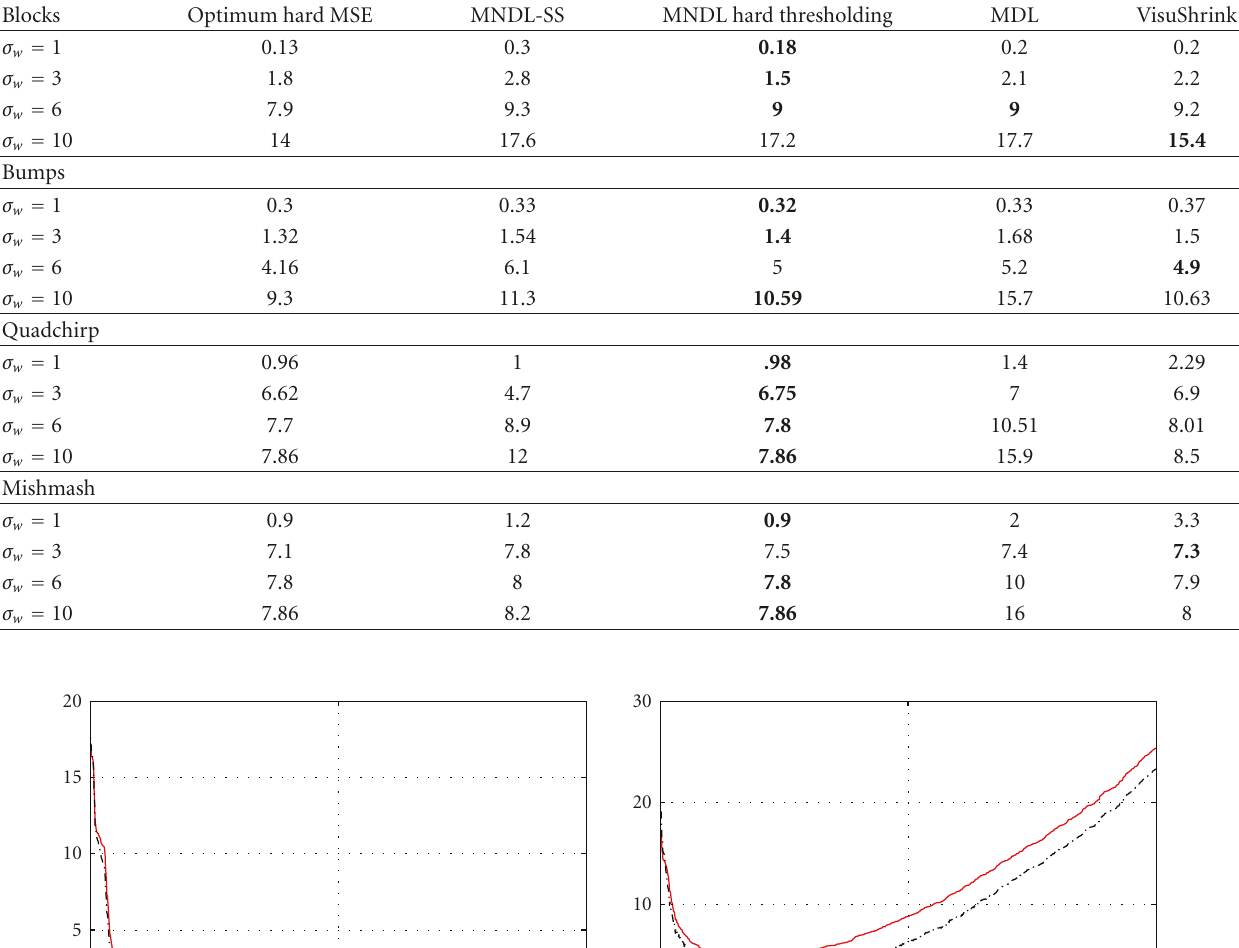
Table 2: MSE comparison of di ff erent thresholding methods with the MNDL hard thresholding approach.